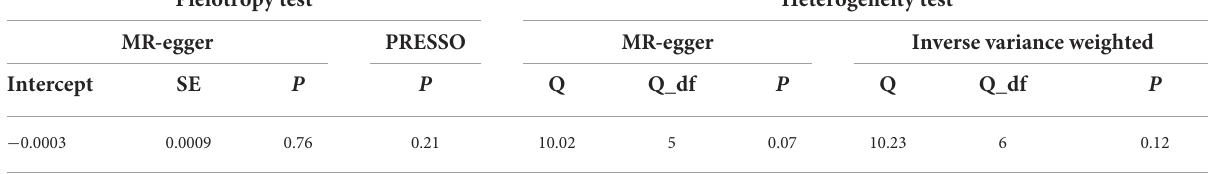
TABLE 2 Pleiotropy and heterogeneity test of PM 2.5 genetic instrumental variables in GWAS for hypothyroidism.